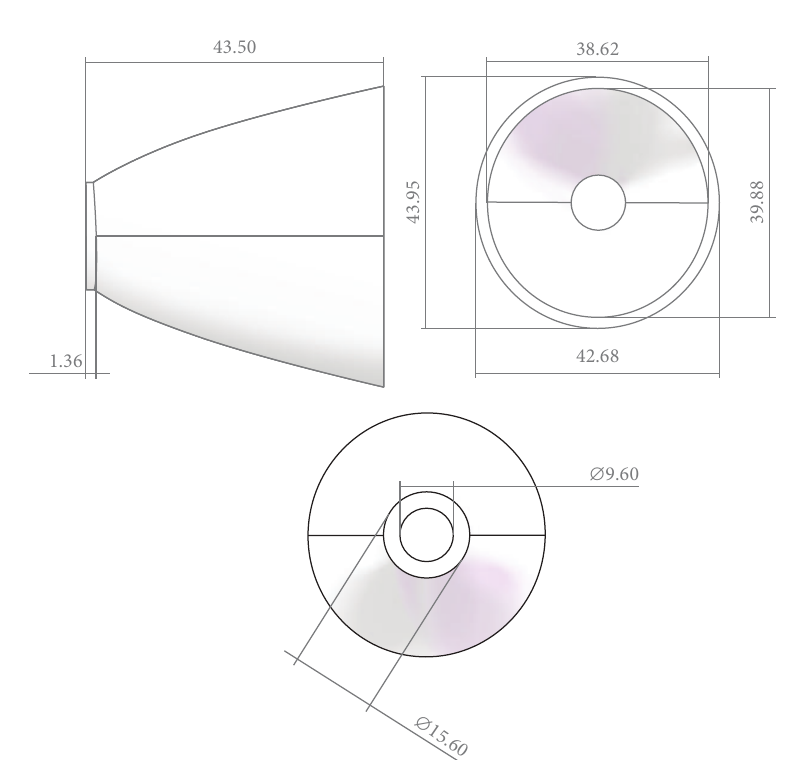
Figure 7: Entity and size of the high beam’s